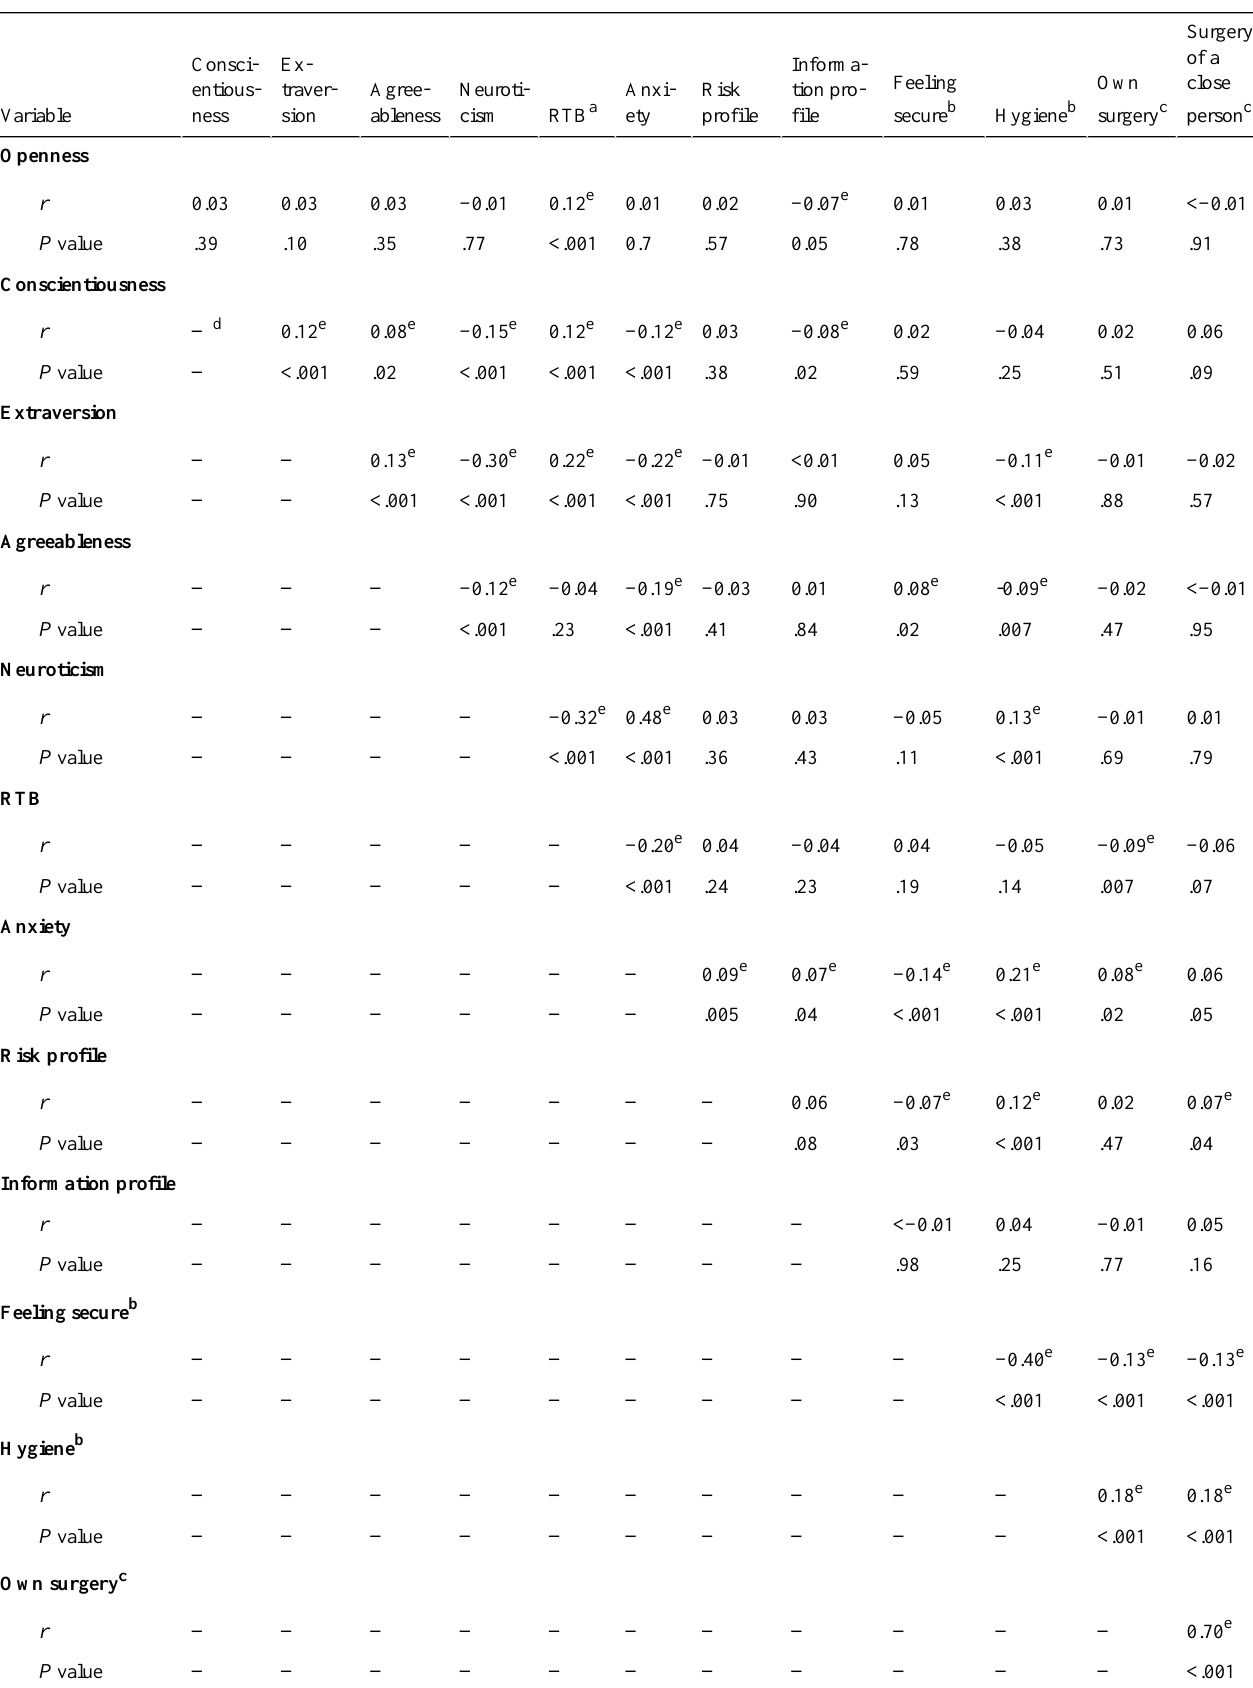
Table 2. Bivariate correlations (ie, r values) among